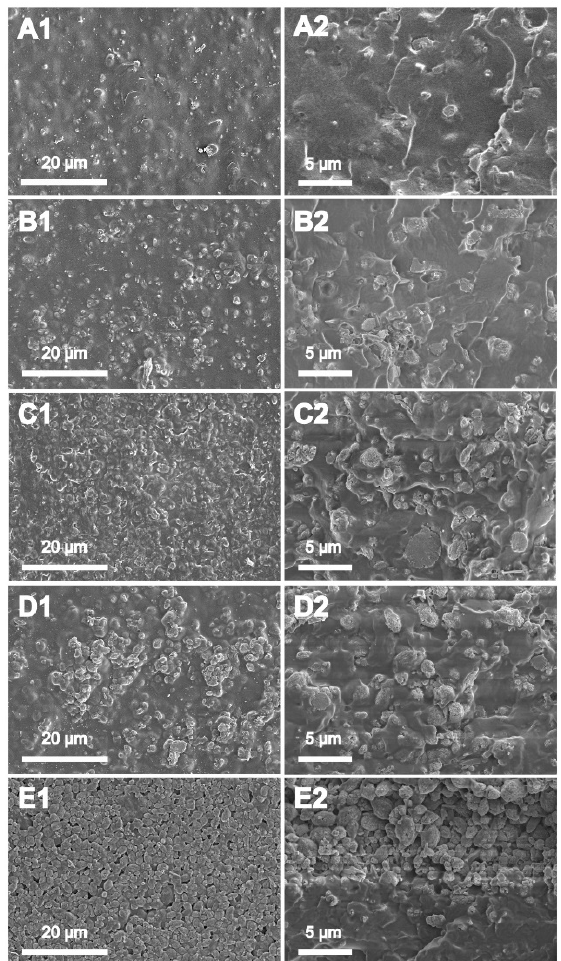
Figure 4. Surface ( A1 – E1 ) and cross-section ( A2 – E2 ) morphologies of ZSM-5 / PVA-based mixed matrix membranes (MMMs): ( A ), ( B ), ( C ), ( D ) and ( E ) are 20 wt%, 30 wt%, 40 wt%, 50 wt%, and 60 wt% zeolite doping content, respectively.